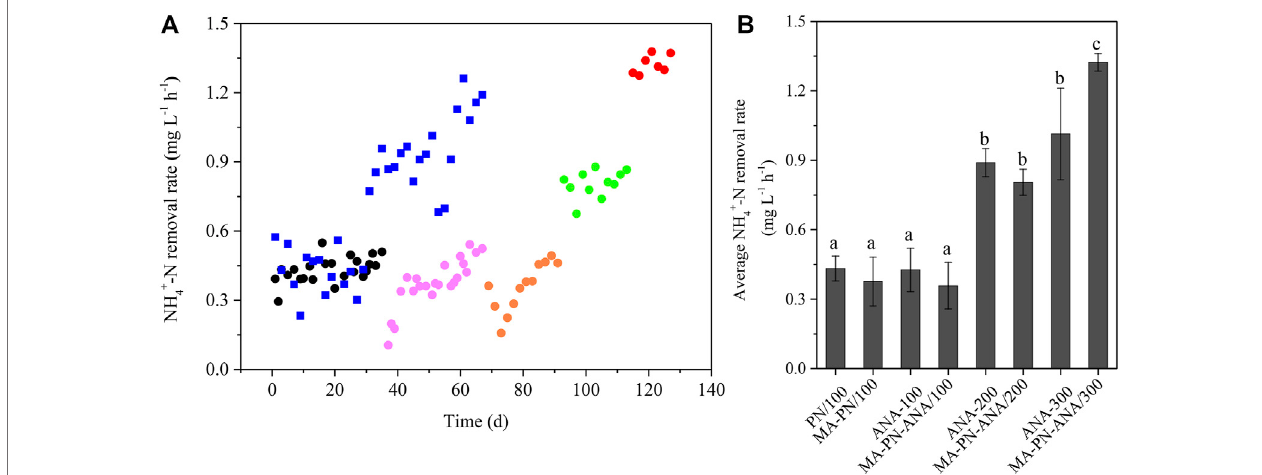
FIGURE 8 | NH 4 + -N removal rates at distant stages. (A) Black circles denote PN stage at 100 mg L − 1 of NH 4 + -N; pink circles denote algae-intensi fi ed PN stage at 100 mg L − 1 of NH 4+ -N; orange circles denote algammox stage at 200 mg L − 1 of NH 4+ -N; green circles denote algammox stage at 300 mg L − 1 of NH 4+ -N; and blue squares denote anammox stage during which NH 4+ -N levels increased from 100 (Day 1 – 29), to 200 (Day 31 – 49), to 300 (Day 51 – 67) mg L − 1 . (B) PN/100 and MA-PN/ 100 indicate PN stage and algae-intensi fi ed PN stage at 100 mg L − 1 of NH 4+ -N. MA-PN-ANA/100, MA-PN-ANA/200, and MA-PN-ANA/300 indicate algammox stage at 100, 200, and 300 mg L − 1 of NH 4+ -N, respectively. ANA/100, ANA/200, and ANA/300 indicate anammox stage at 100, 200, and 300 mg L − 1 of NH 4+ -N, respectively. The average NH 4+ -N removal rates for PN/100 ( n = 23), MA-PN/100 ( n = 22), MA-PN-ANA/100 ( n = 12), MA-PN-ANA/200 ( n = 11), MA-PN-ANA/300 ( n = 7), ANA/100( n =15),ANA/200( n =10), andANA/300( n =9)areexpressedasmean±SD.Thedistinctletterslabeled fortheaverageNH 4+ -Nremovalratesindicatethe statistically signi fi cant difference by Tukey ’ s HSD test.